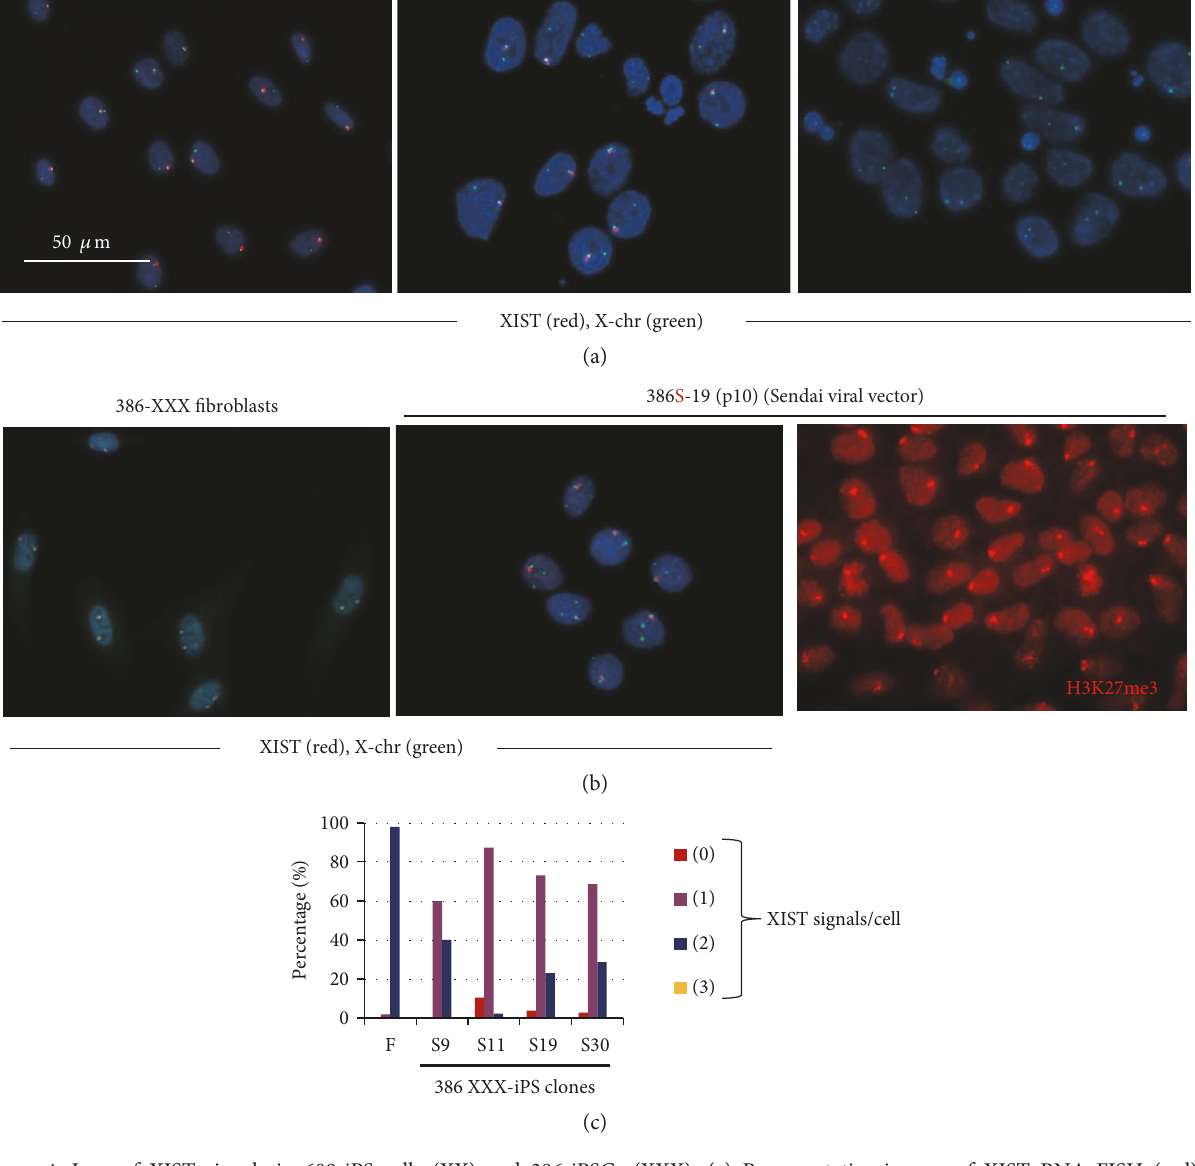
Figure 4: Loss of XIST signals in 609-iPS cells (XX) and 386-iPSCs (XXX). (a) Representative images of XIST RNA FISH (red)/X chromosome-DNA FISH (green) on 609 fi broblasts, 609-2 iPS cells (passage 5: p5), and 609S-1 iPS cells (p10). 609 fi broblasts have one XIST signal. Most 609-2 iPS cells retain XIST expression. In contrast, 609S-1 iPS cells, which were generated with Sendai viral vectors, had totally lost XIST expression. Quantitative data are also shown in Table 2. (b) Representative images of XIST RNA FISH (red)/X chromosome-DNA FISH (green) on 386 fi broblasts, and 386-S19 iPS cells. 386 fi broblasts have three X and two XIST signals. 386-S19 iPS cells, which were induced using Sendai viral vectors retained one XIST expression. Trimethyl-histone H3 (Lys27) (H3K27me3) signals (red) in 386-S19 iPS cells are shown. Most cells have just one H3K27me3 signal/cell. (c) XIST signals per cell in 386 fi broblasts and four 386 iPS cells. 386 fi broblasts have three X chromosomes and two XIST signals. In four 386 iPS clones, which were induced with Sendai viral vectors, most cells have one XIST